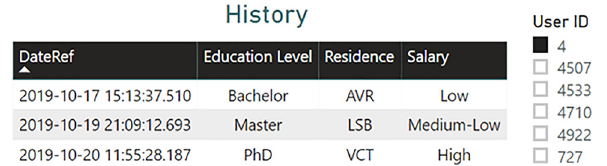
Figure6: HistorytableoftheuserwithID4containingthe modified records regarding education level, residence and